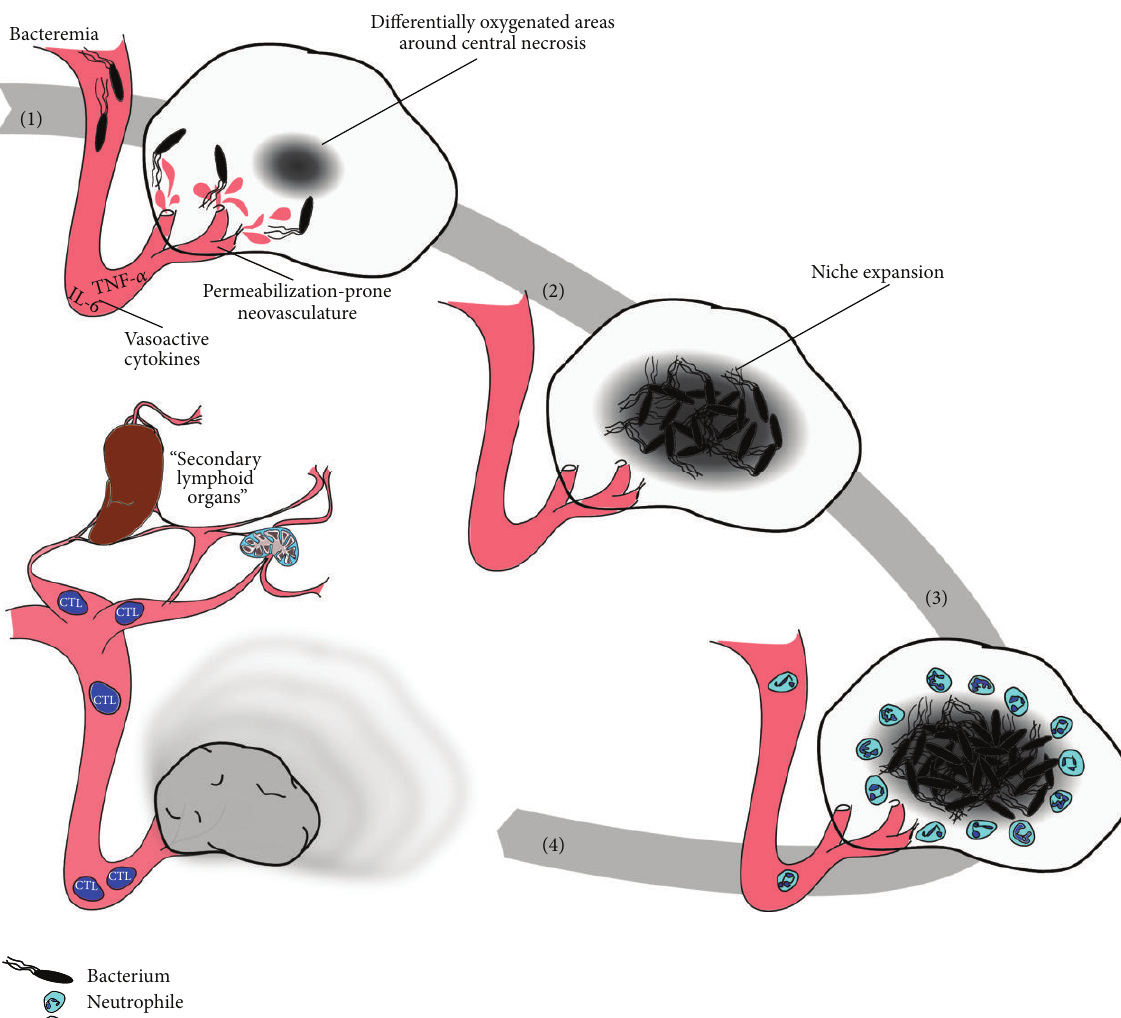
Figure 1: Biological events of the intrinsic tumor therapeutic effect of Salmonella . Steps (1)–(4) depict major biological events associated with an antitumor effect induced by Salmonella infection. (1) Tumor invasion. (2) Colonization. (3) Infection control. (4) Antitumor response and tumor regression. (1) Presence of bacteria in the blood stream (bacteremia) induces a cytokine storm, which is dominated by vasoactive cytokines that facilitate passive deposition of bacteria in the tumor during the induced hemorrhage. (2) Invading bacteria accumulate, localize to a preferable growth environment (low p0 2 , immune privileged site), and proliferate to saturation. (3) Colonization brings about change to the tumor microenvironment, including attraction and polarization of innate effector cells and cytokines in favor of antibacterial control and tumor immune surveillance. (4) Tumor regression occurs in response to multimodal therapeutic effects, including an adjuvant effect on preestablished tumor immune surveillance, polarization of innate effectors’ phenotype, direct cytotoxicity, and passive